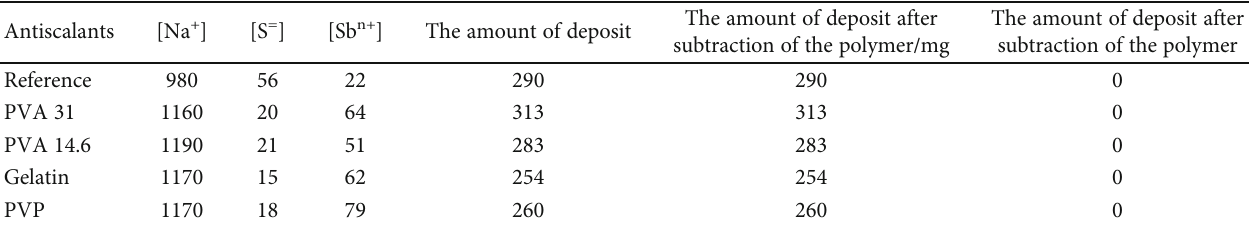
Table 2: Concentration of several of ions (mg · L -1 ) in the decantate solution after isolation of solid content so-called deposit. Dosage of the antiscalants is 5 ppm. The reference points out the reaction carried out in absence of antiscalants. Antiscalants The amount of deposit